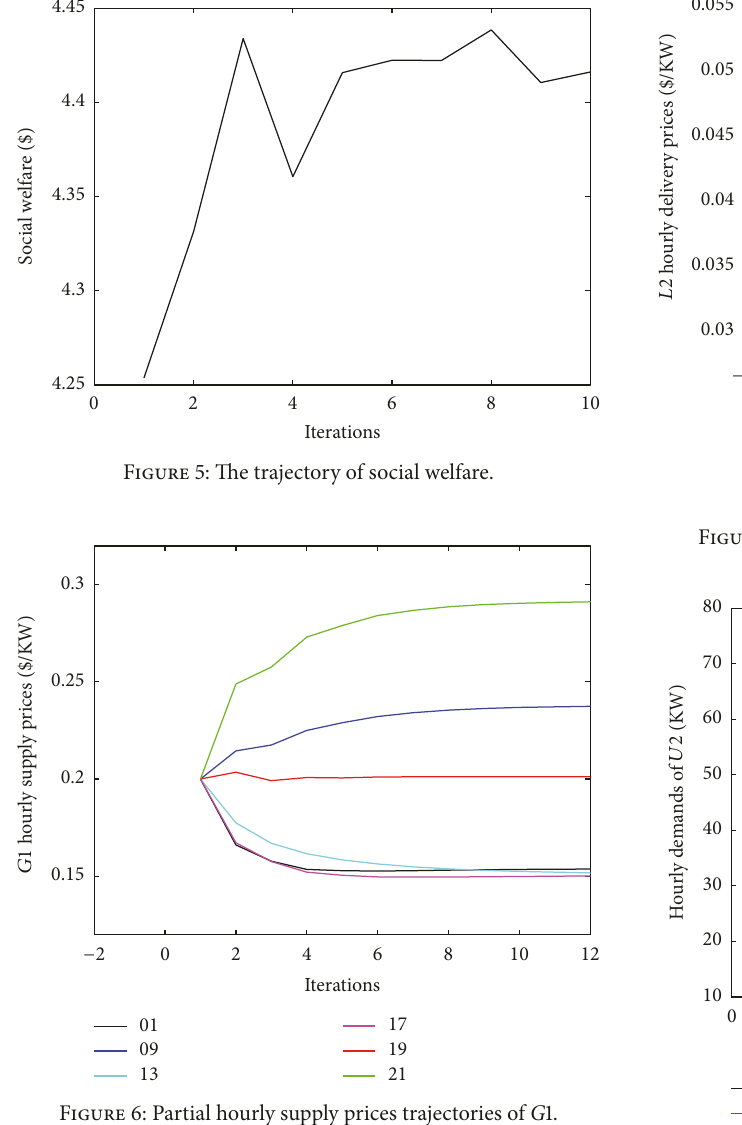
Figure 8: The demand shifting of day-ahead scheduling of U